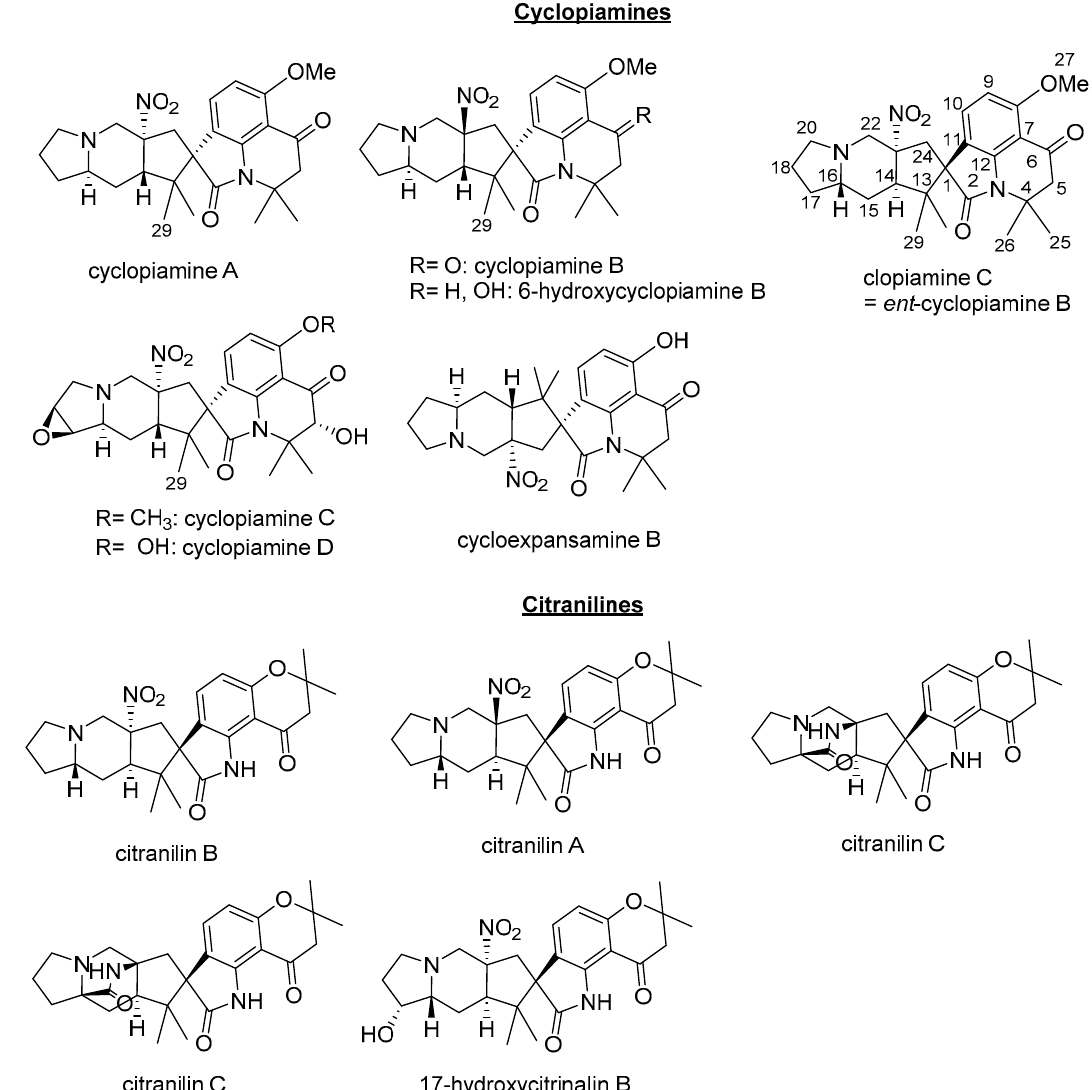
Figure 1. Structures of Cyclopiamines and Citranilines.